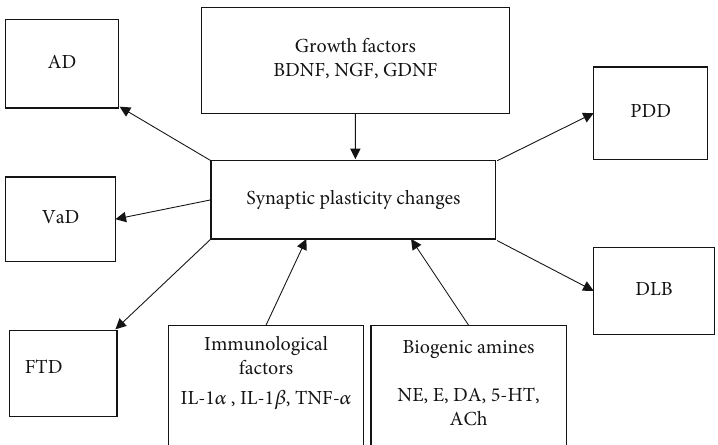
Figure 4: Changes in the level of neurotrophins and synaptic plasticity in the development of dementia diseases. AD: Alzheimer ’ s disease; FTD: frontotemporal dementia; VaD: vascular dementia; DLB: dementia with Lewy bodies; PDD: Parkinson ’ s disease (PD) dementia; BDNF: brain-derived neurotrophic factor; NGF: nerve growth factor; GDNF: glial-cell-derived neurotrophic factor; NE: norepinephrine; E: epinephrine; DA: dopamine; 5-HT: serotonin; ACh: acetylcholine; IL-1 α : interleukin-1alpha; IL-1 β : interleukin-1beta; IL-6: interleukin 6; TNF- α : tumor necrosis